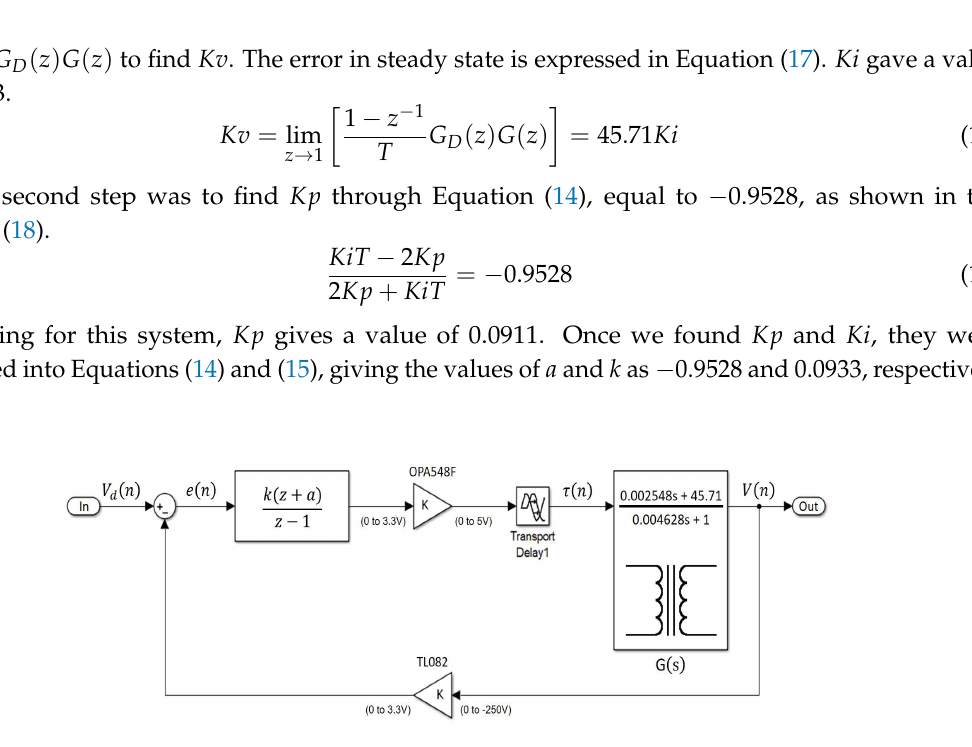
Figure 11. Experimental setup for the tuning process by the analytical design method (ADM).